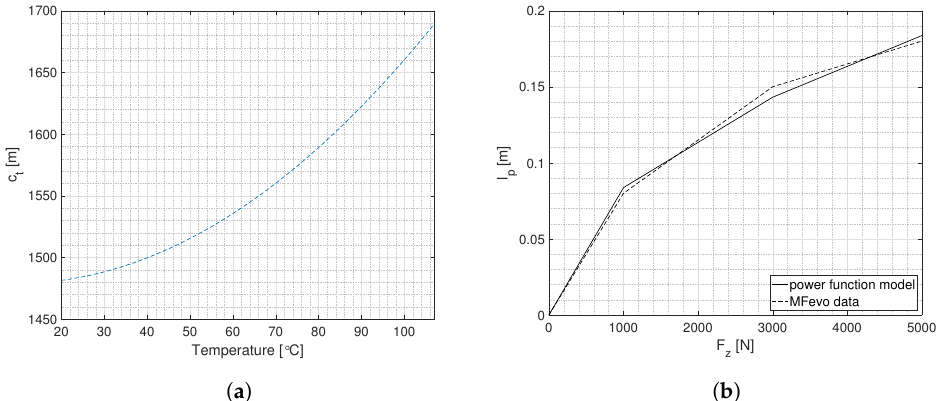
Figure 8. MFevo specific heat capacity variation with tread temperature, and patch length variation with tyre normal load. ( a ) c t ( T s ) ; ( b ) l p ( F z ) .